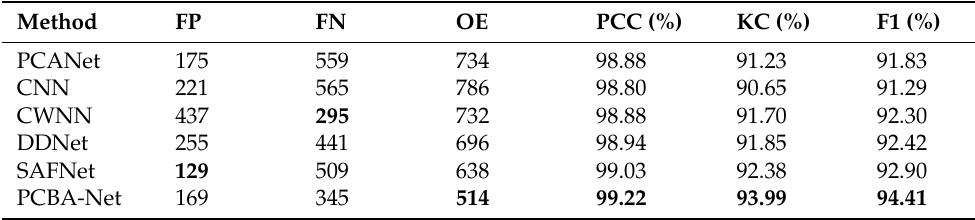
Figure 12. Visualization of comparative experiments for the San Francisco dataset. ( a ) Ground-truth image. ( b ) Result of PCANet. ( c ) Result of CNN. ( d ) Result of CWNN. ( e ) Result of DDNet. ( f ) Result of SAFNet. ( g ) Result of the presented PCBA-Net. Table 3. Change detection results for San Francisco dataset.